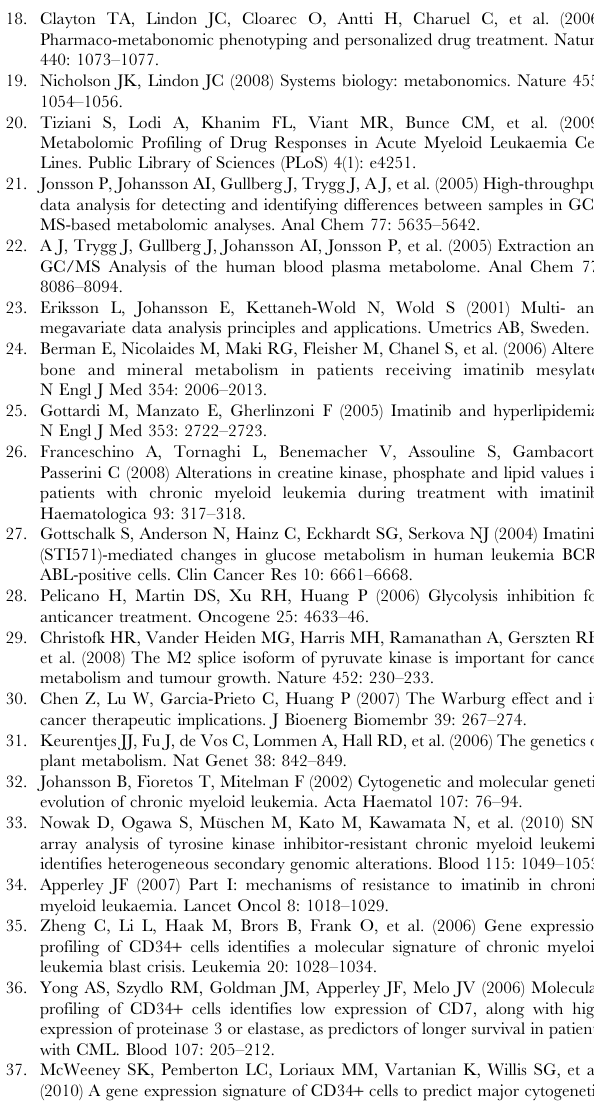
Figure S2 The PLS_DA scores plot of RCML BC ( & , n= 6) and RCML CP ( % , n =8) patients. RCML BC patients showed totally different metabonomic phenotype from that of RCML CP patients. Figure S3 Metabolic perturbations in UCML and metabolic response to imatinib treatment. The marked metabolites were observed at an abnormal level in UCML, and most of them were regulated towards normal in SCML with imatinib. Red or green blocks represent a statistically significant higher or lower level(p , 0.05, one-way ANOVA) in UCML in comparison with the healthy control, respectively. Pink and blue blocks represent a higher or lower (not statistical significance, p . 0.05, one-way ANOVA) level in UCML in comparison with healthy control, respectively. Table S1 Compounds identified in human blood plasma.